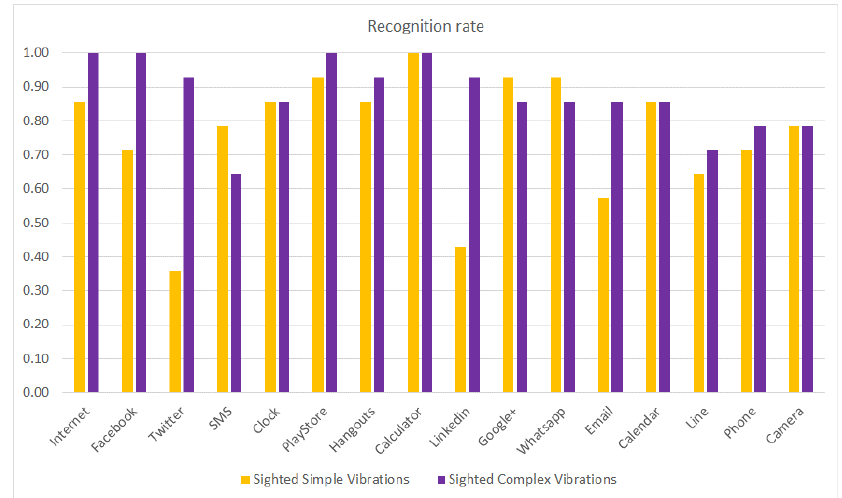
Figure 7. Recognition rate per haptic icon for sighted people using simple and complex vibration patterns.